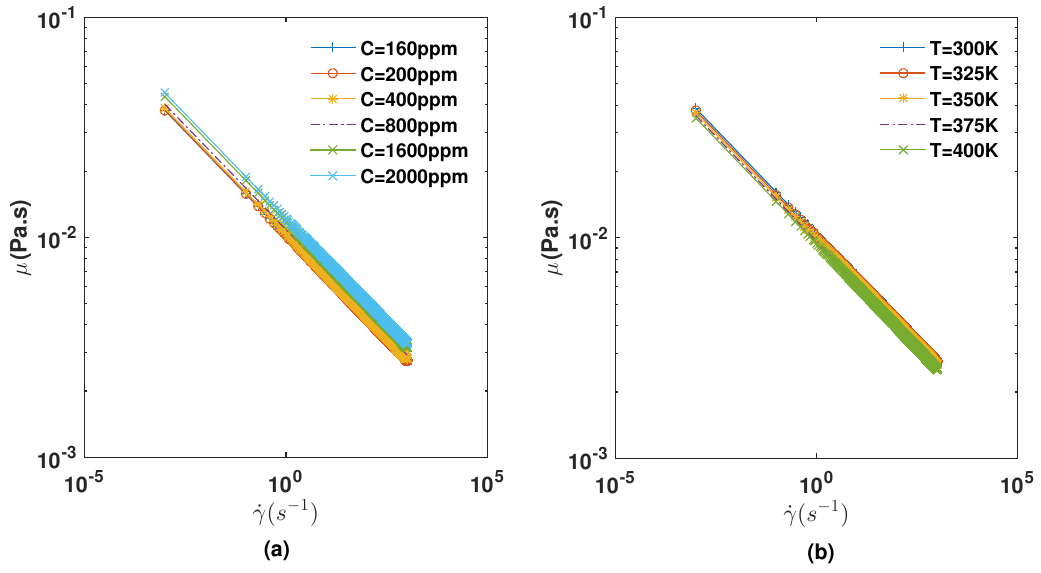
Figure 1. Temperature-Concentration Dependent Power-Law Viscosity Fluid Function of the Shear Rate at Different (a) Concentrations and (b) Temperature from Eq. (9). Table 1. Typical values of the viscosity model parameters